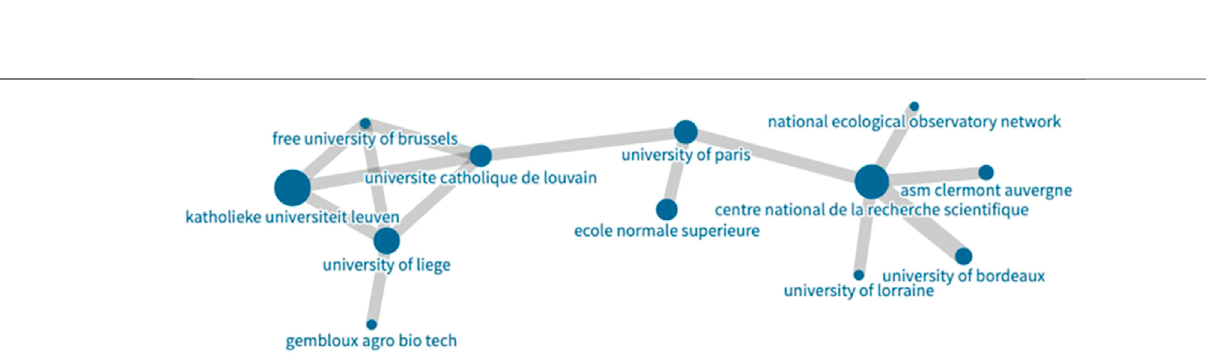
FIGURE 9 | The single largest component of the author network, with communities indicated by